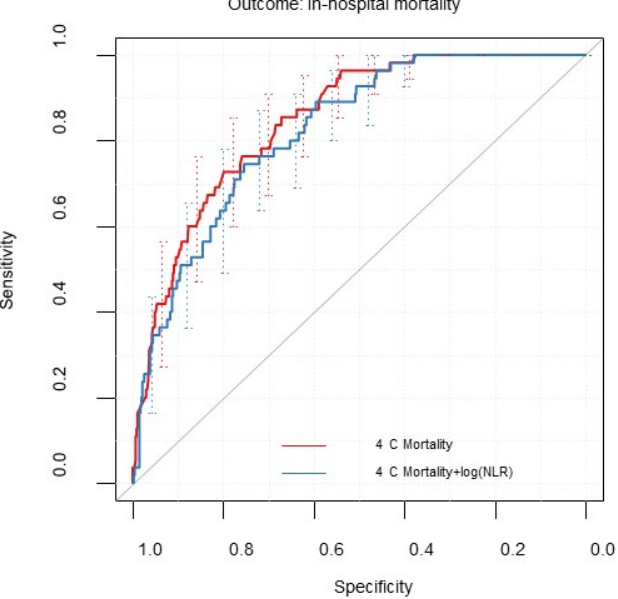
Figure 3. Receiver operating characteristic curve for modified 4C Mortality Score and updated models including the natural log transformed predictor neutrophil-to-lymphocyte ratio (NLR). Evaluated for the first imputed data set (m = 1) with 95% confidence intervals calculated by bootstrapped resampling (2000 samples).